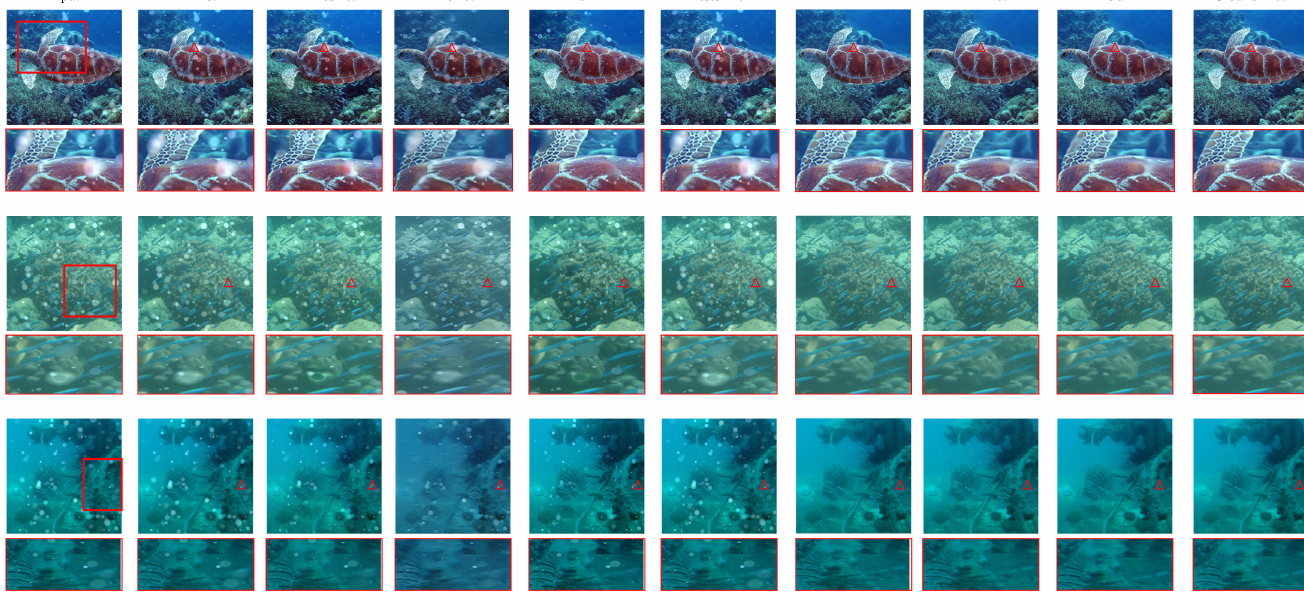
Figure 7. Comparison results of UIR-Net with the seven other methods on the MSRB dataset.